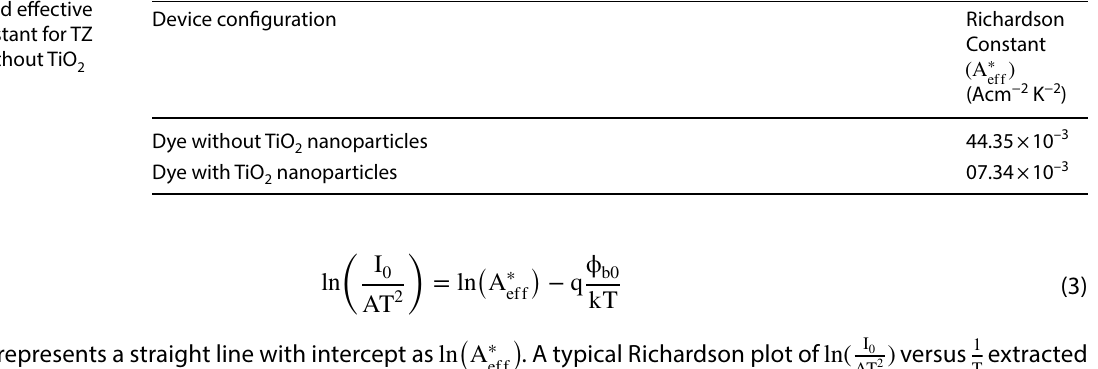
Table 1 Extracted effective Richardson Constant for TZ dye with and without TiO